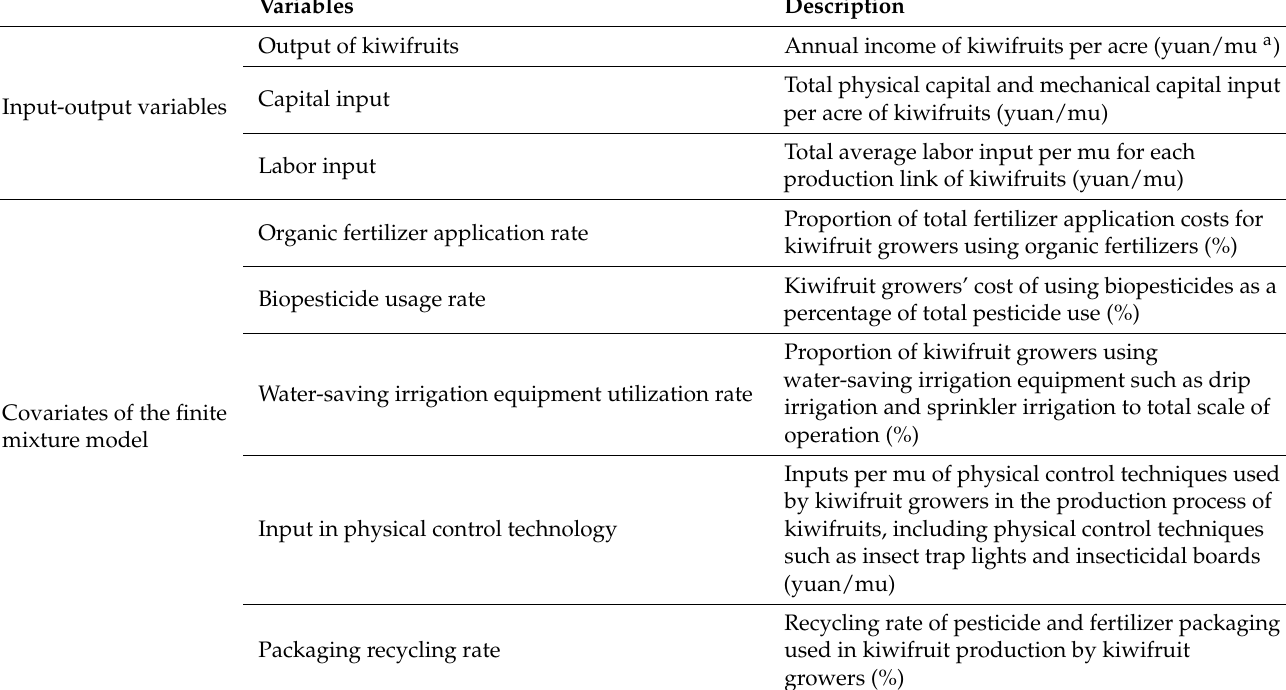
Table 1. Descriptive statistics for measuring the main variables of green agricultural production